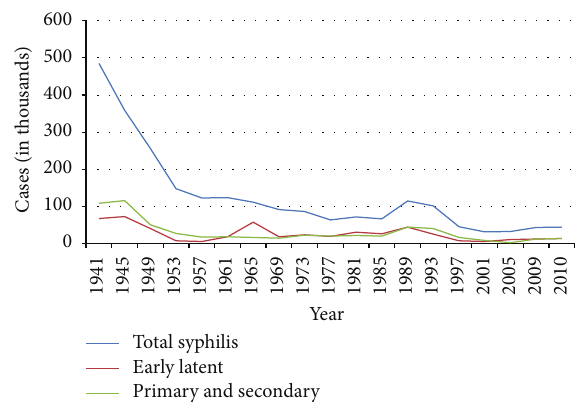
Figure 1: Syphilis—Reported Cases by Stage of Infection, United States, 1941–2010. Centers for Disease Control and Prevention. STD Trends in the United States 2012 . Atlanta: U.S. Department of Health and Human Services; 2012.